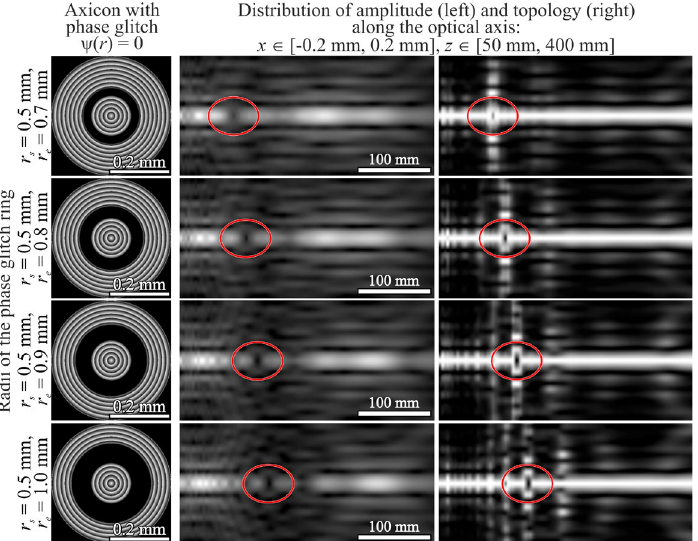
Figure 7. Modeling results for the formation of optical bottles due to axicons with phase apodization ψ( r ) = 0 in Equation (21) under Gaussian beam illumination.